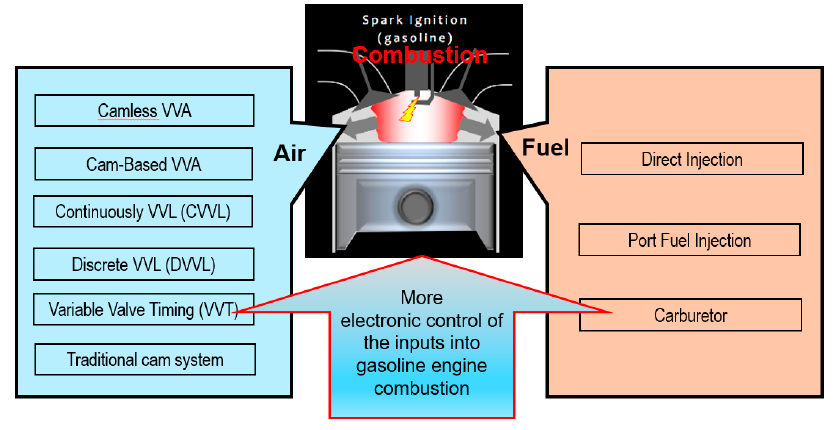
Figure 1. More electronic control of inputs into gasoline engine combustion .